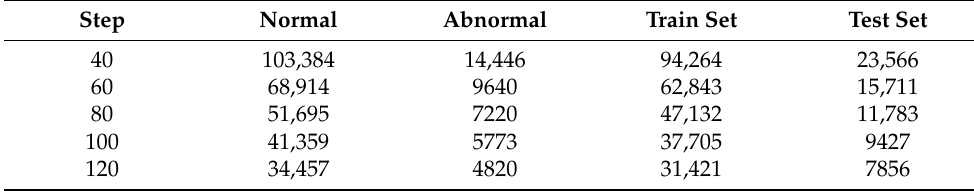
Table 6. Effect of step on the number of log event sequences.